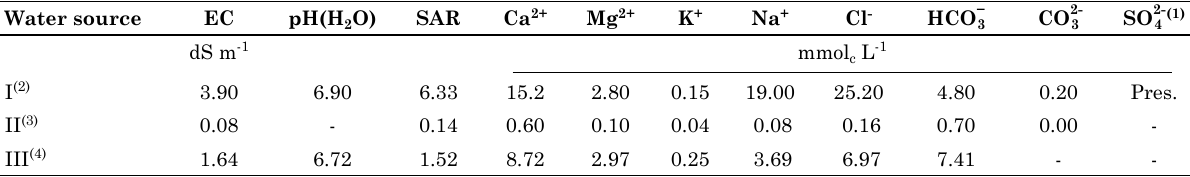
Table 5. Water chemical analysis used for fertilizer recommendation by Ferticalc-melon system Water source